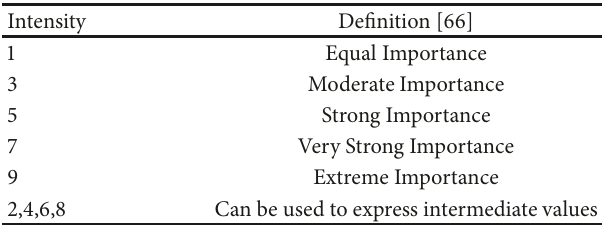
Table 5: AHP analysis